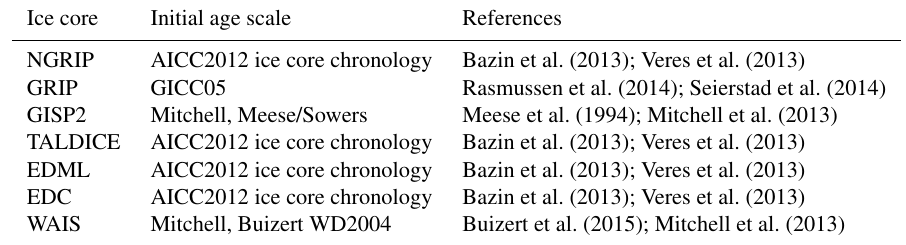
Table 2. Ice cores and age scales. Short names of the ice cores and initial gas age scales used for the CH 4 compilation.